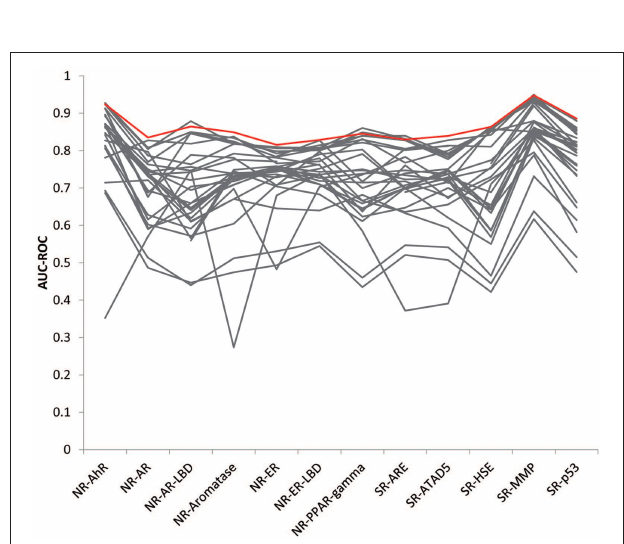
FIGURE 3 | Factors influencing model performance (displayed as mean AUC-ROC ± standard deviation). Assays that had higher active rates received better models. No correlation was found between data reproducibility and model performance because all assays were highly reproducible.